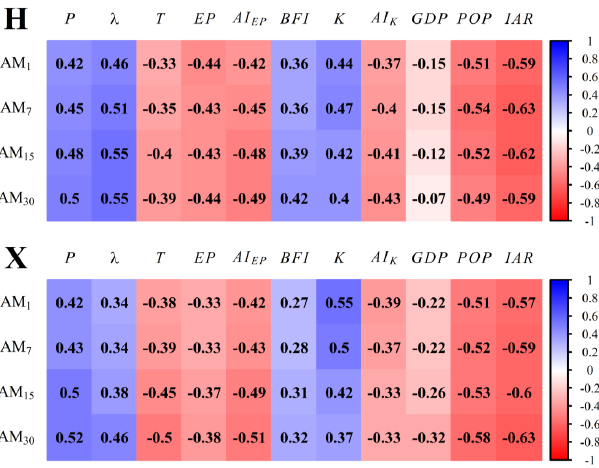
Figure 6. The Pearson correlation coefficients matrix between the annual minimum flow series and candidate explanatory variables in Huaxian (H) and Xianyang (X) stations; the darker color intensity represents a higher level of correlation (blue indicates positive cor- relation and red indicates negative